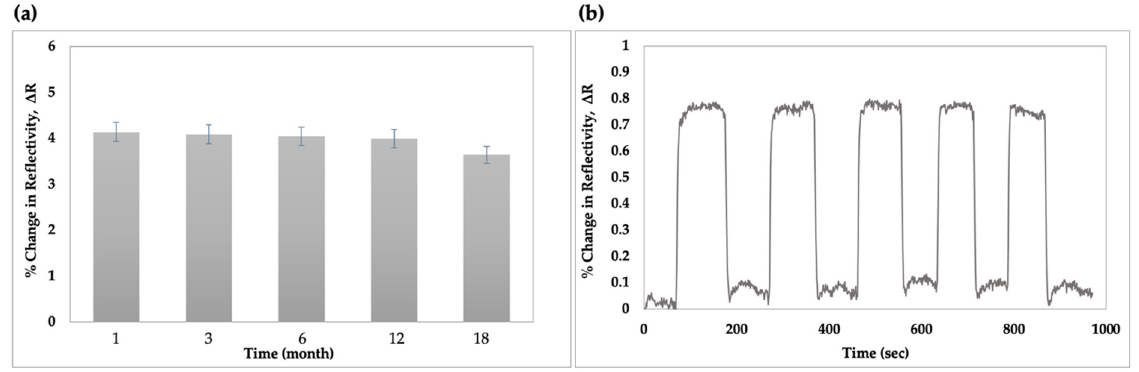
Figure 7. ( a ) Storage stability and ( b ) reusability of AFM1 − imprinted plasmonic sensor.